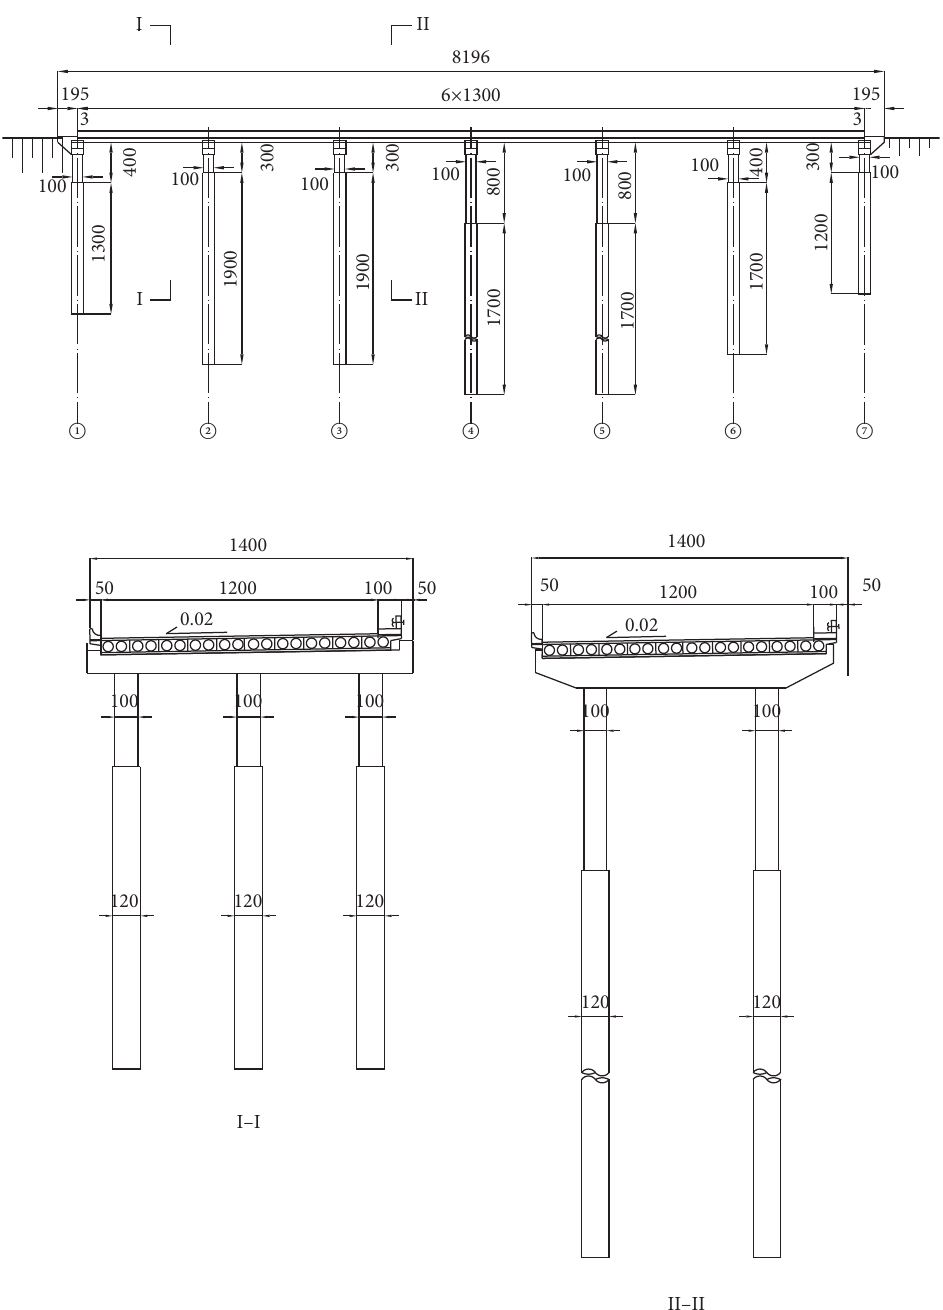
Figure 5: Layout of case